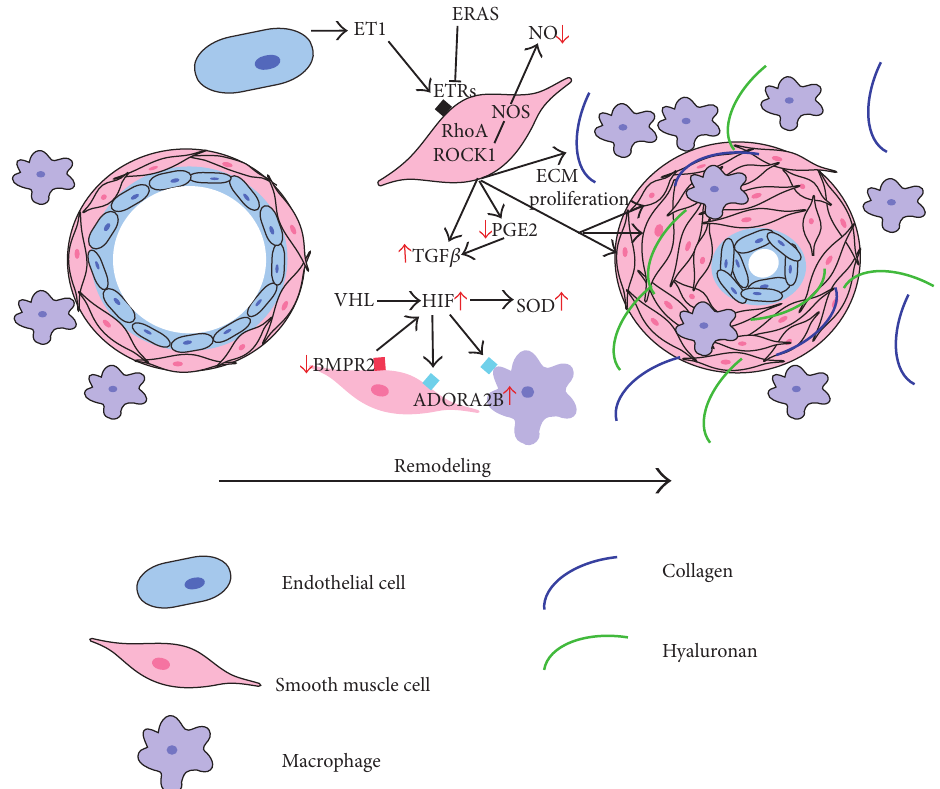
Figure 1: Cellular processes and mediators involved in the pathogenesis of PH associated with lung